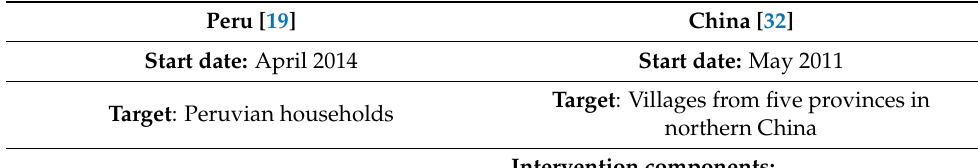
Table 1. Population-level low-sodium salt intervention